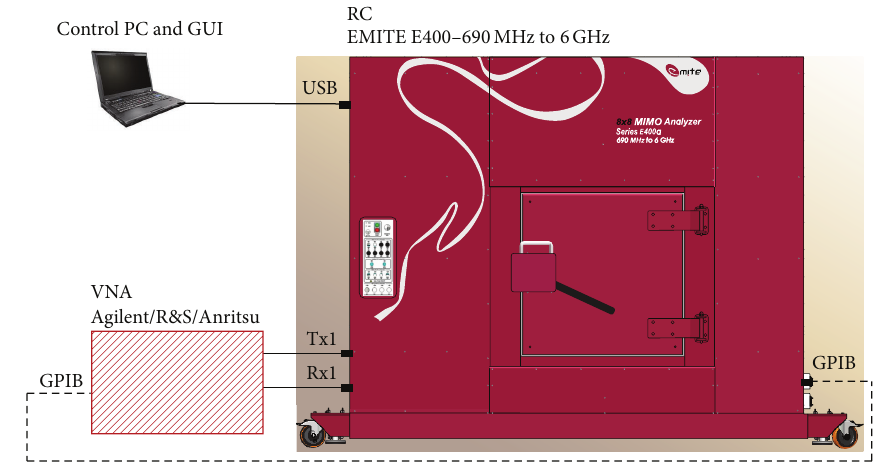
Figure 2: E400 MIMO analyzer reverberation chamber test setup.